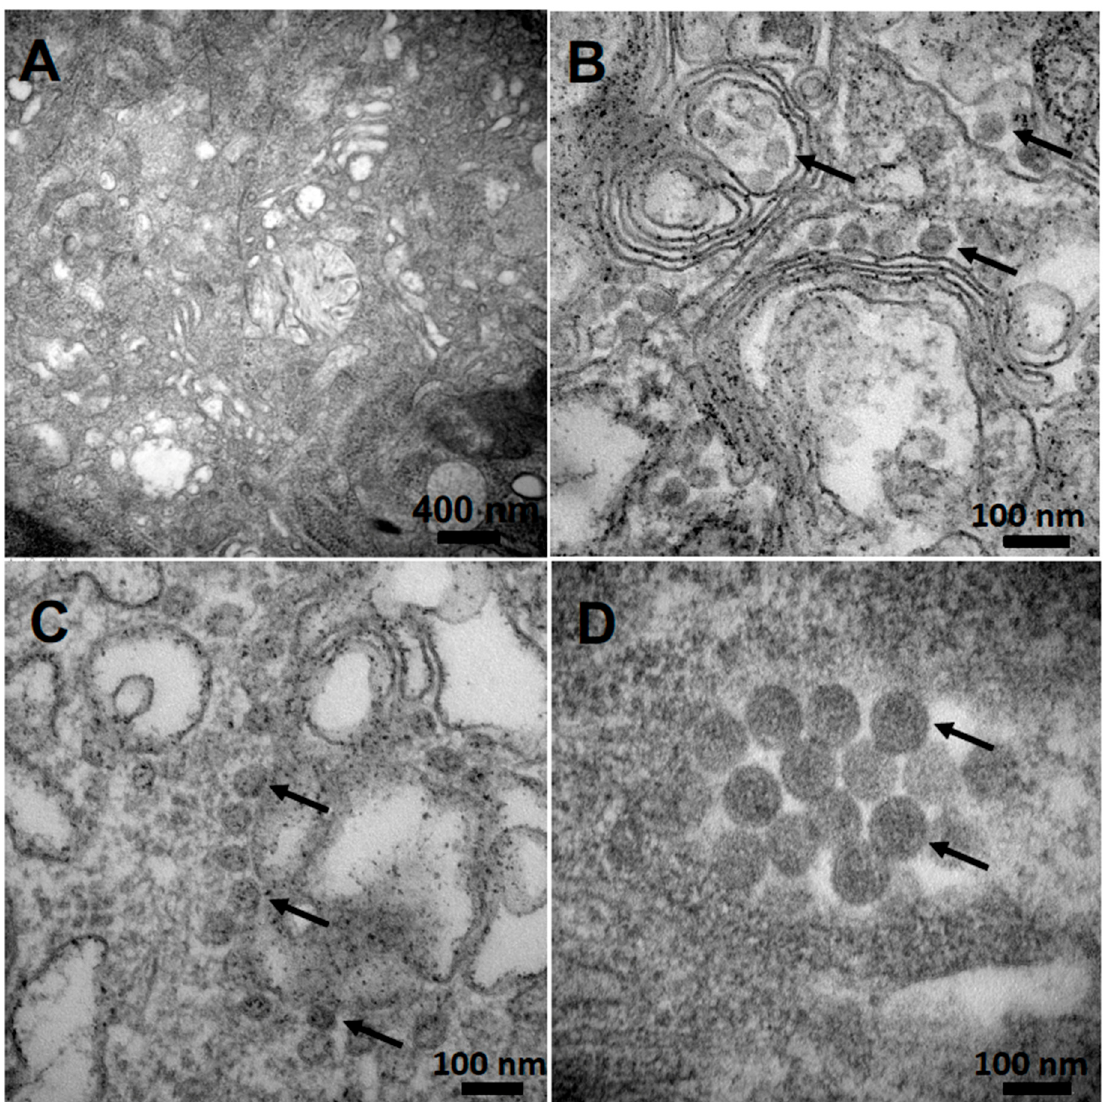
Figure 3. TEM images of Vero E6 cells infected with SFTSV from Passage 3. ( A ) uninfected controls; ( B , C ) cells with the viral particles (indicated by arrows) at day 3 post-infection; ( D ) magnified view (direct mag: 150,000 × ) of the viral particle structures (indicated by arrows) at day 6 post- infection.